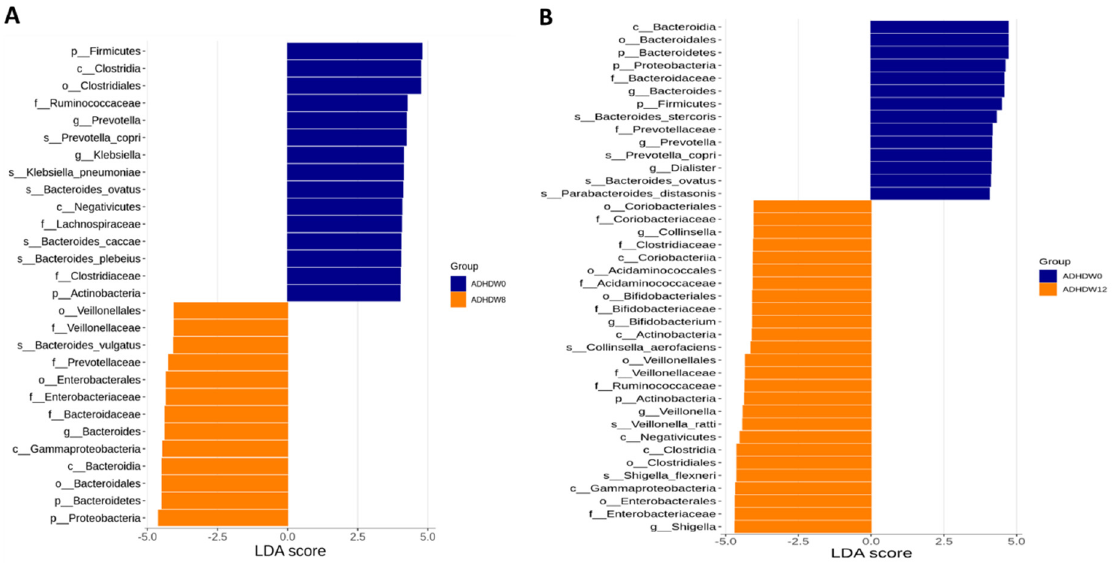
Figure 6. Flora with significant differences between baseline and the 8th week ( A ) and between baseline and the 12th week ( B ). The orange bars represent flora with higher abundances after taking probiotics (week 8). The blue bars show flora with higher expressions at the baseline.